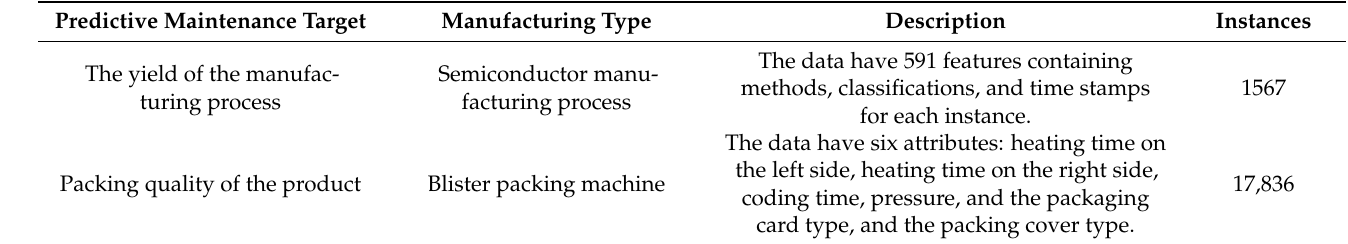
Table 2. List of